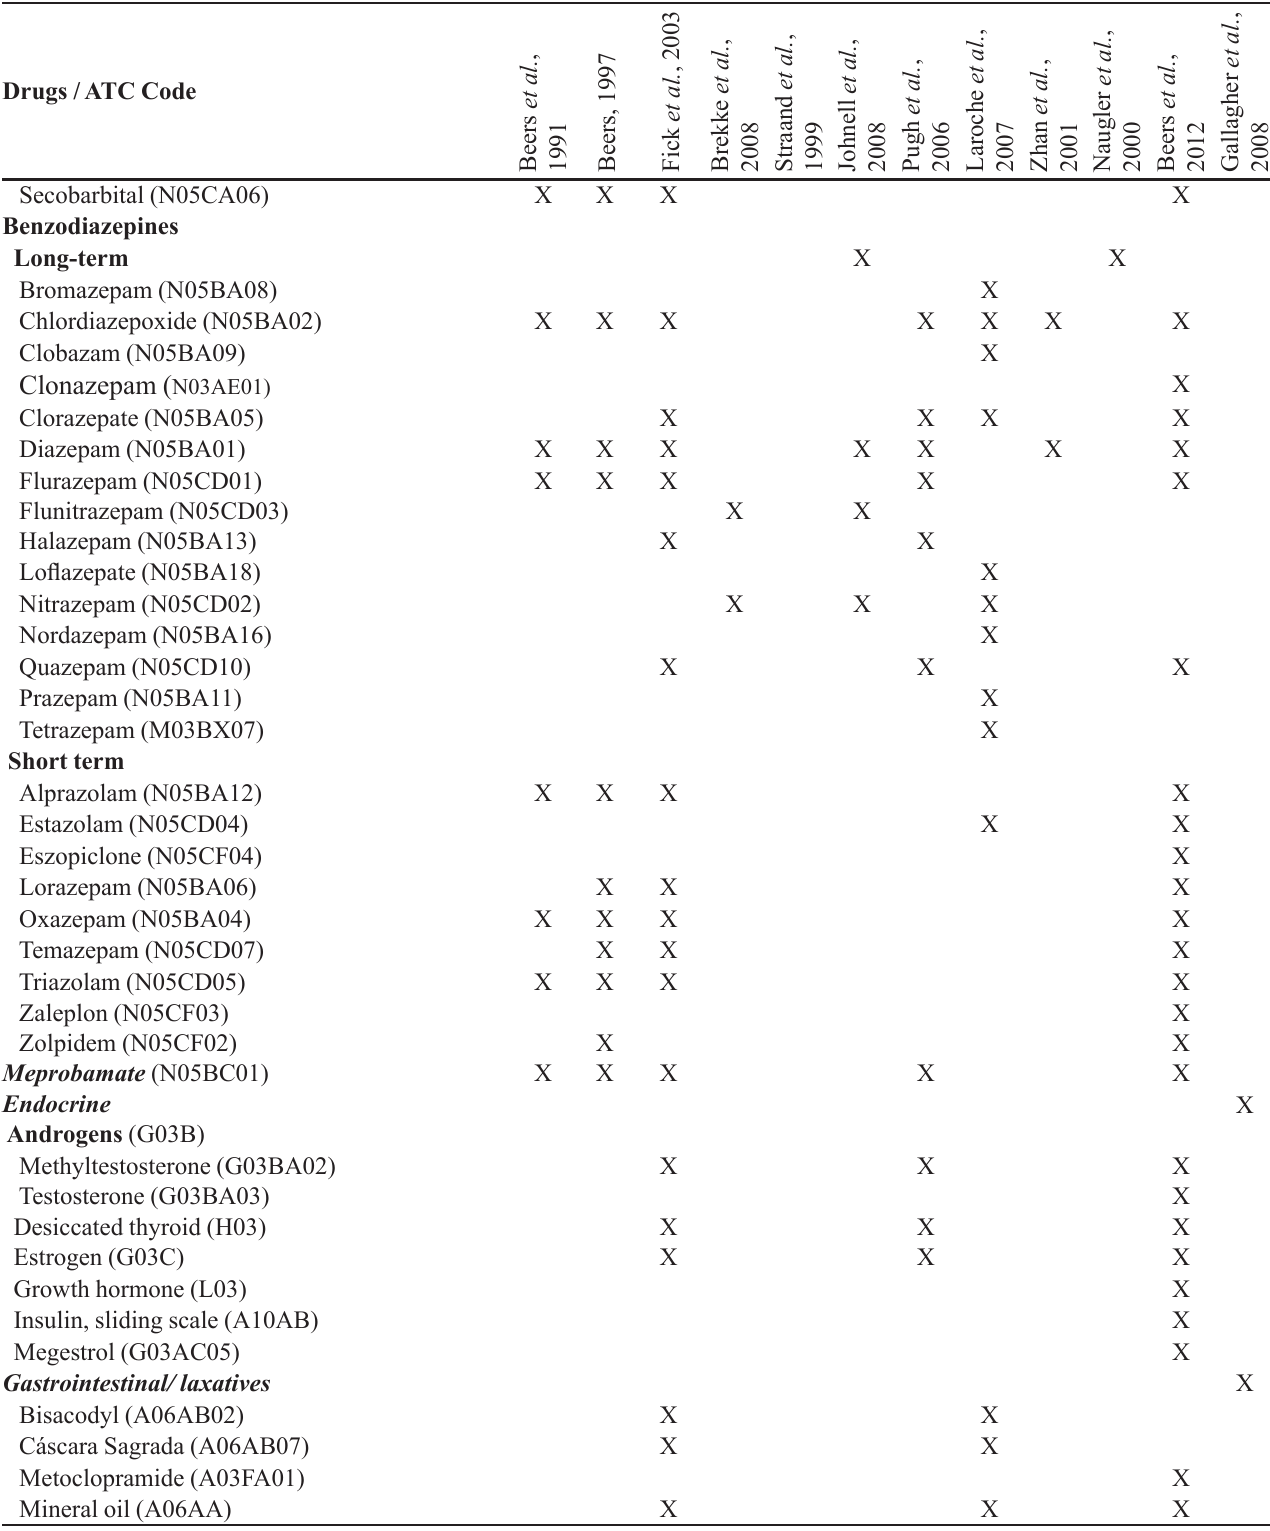
TABLE I - List of potentially inappropriate medications (PIM) for the elderly that should be avoided irrespective of diagnosis or clinical condition, according to the methods identified in PAHO (available in: http://regional.bvsalud.org/php/index.php), Lilacs and Pubmed databases, during the period between February and March 2010 (n=12)